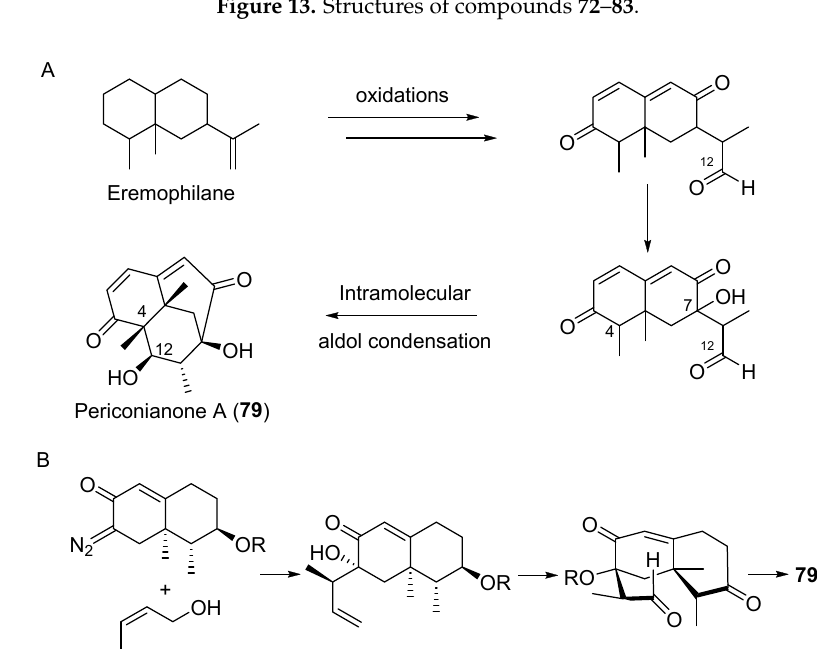
Figure 13. Structures of compounds 72 – 83 .